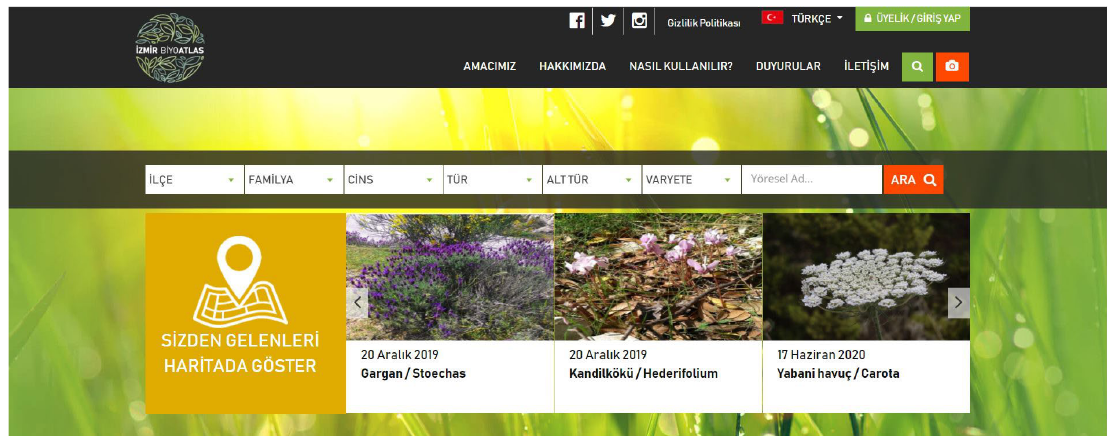
Figure 2 Izmir Biyoatlas Project